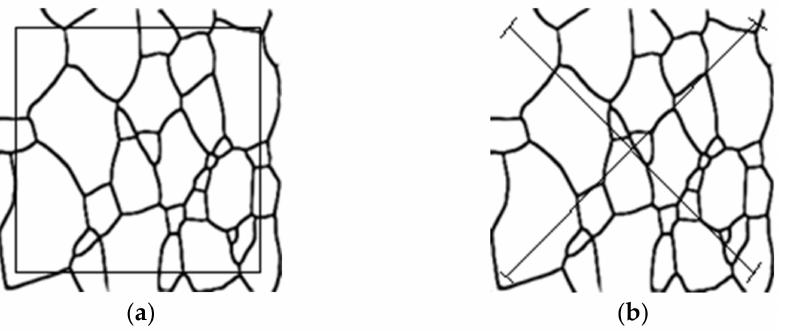
Figure 8. Grain size measurement results according to ASTM E112-12. ( a ) The planimetric method; ( b ) the intercept method.